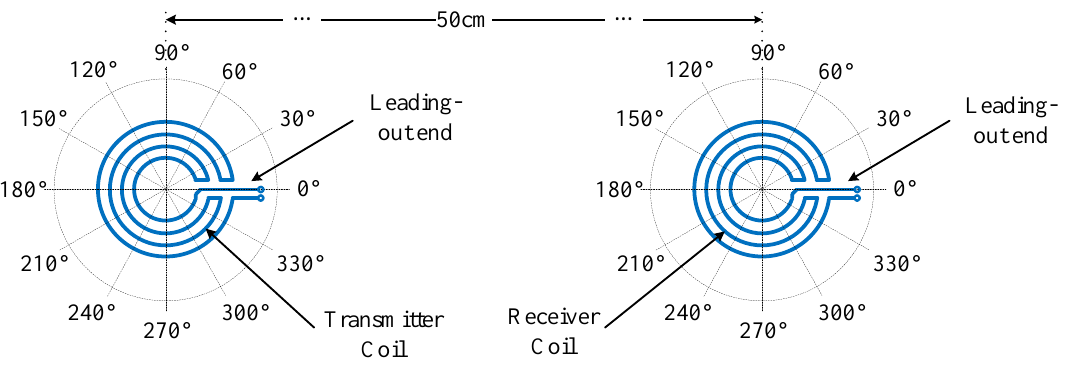
Figure 7. Schematic diagram of the EMATs positions and directions.